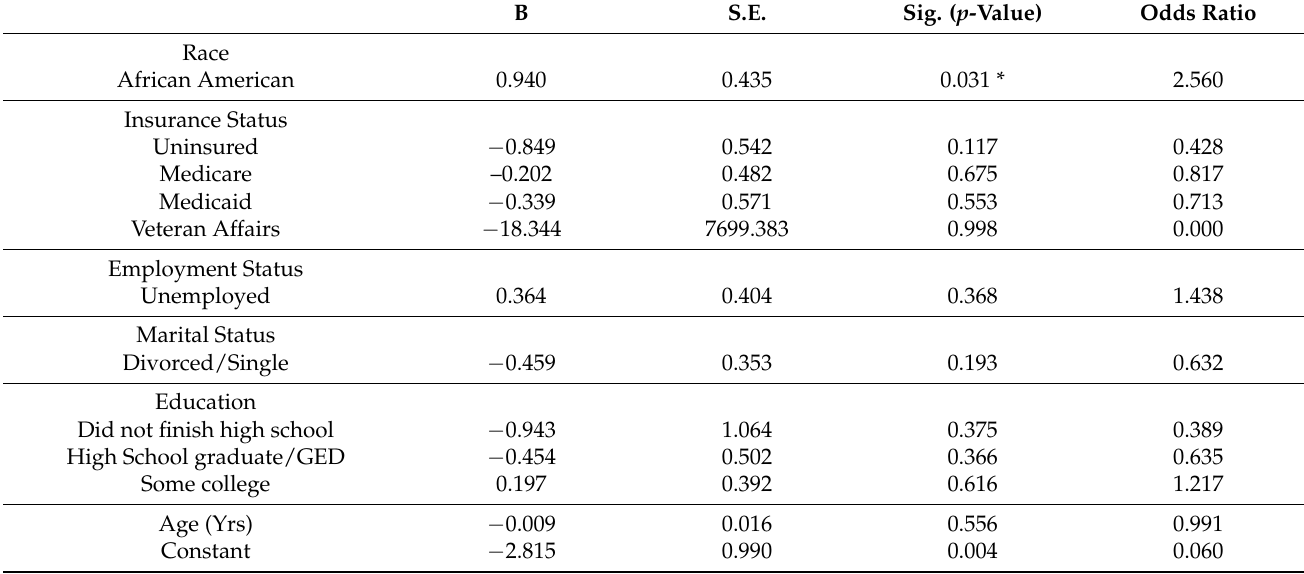
Table 6. Logistic regression for racial differences in COVID-19